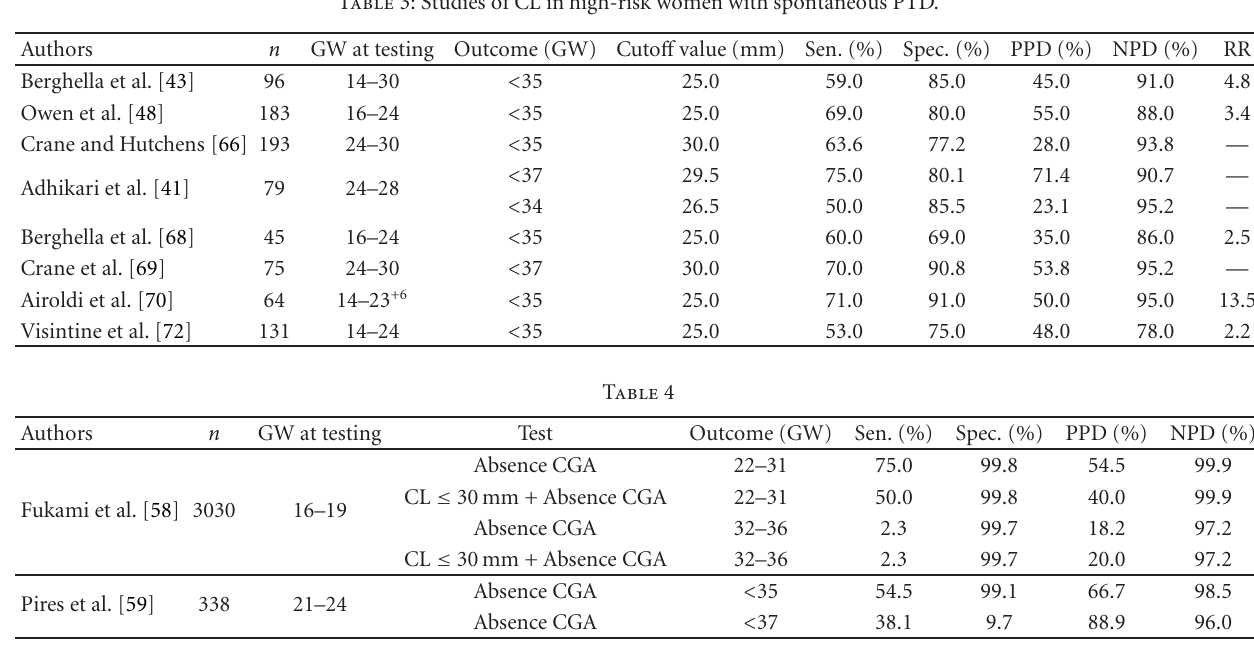
Table 3: Studies of CL in high-risk women with spontaneous